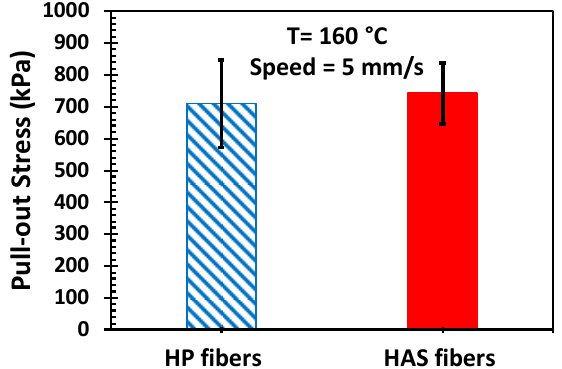
Figure 10. Pull-out stress of HP and HAS microfibers pulled out of the PP matrix. Error bars represent the standard deviation from five tests.